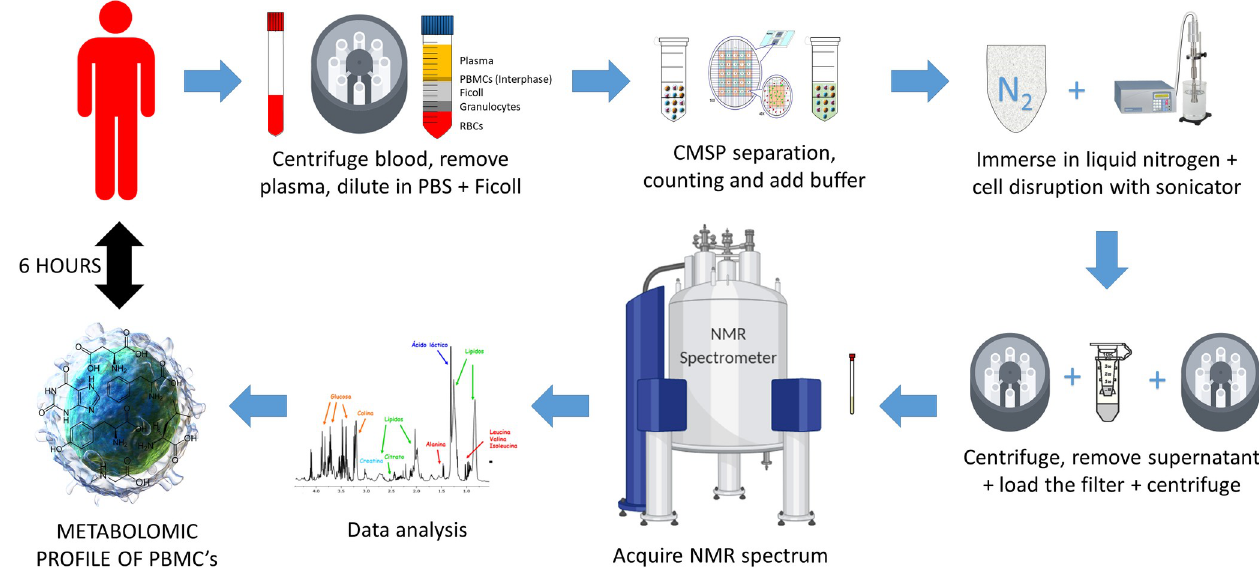
Fig 1. Step by step UUM method. Schematic explanation of PBMC processing by the UUM method (Ultrasound and Ultrafiltration Method). Using these methods, it is possible to obtain the metabolomic profile in 6 h starting from whole blood. The PBMC samples were isolated from the peripheral blood of healthy human individuals. Samples were split into an aliquot (12.5 million cells) for characterization. Finally, PBMC were extracted and the 1 H-NMR metabolic profiles were determined.